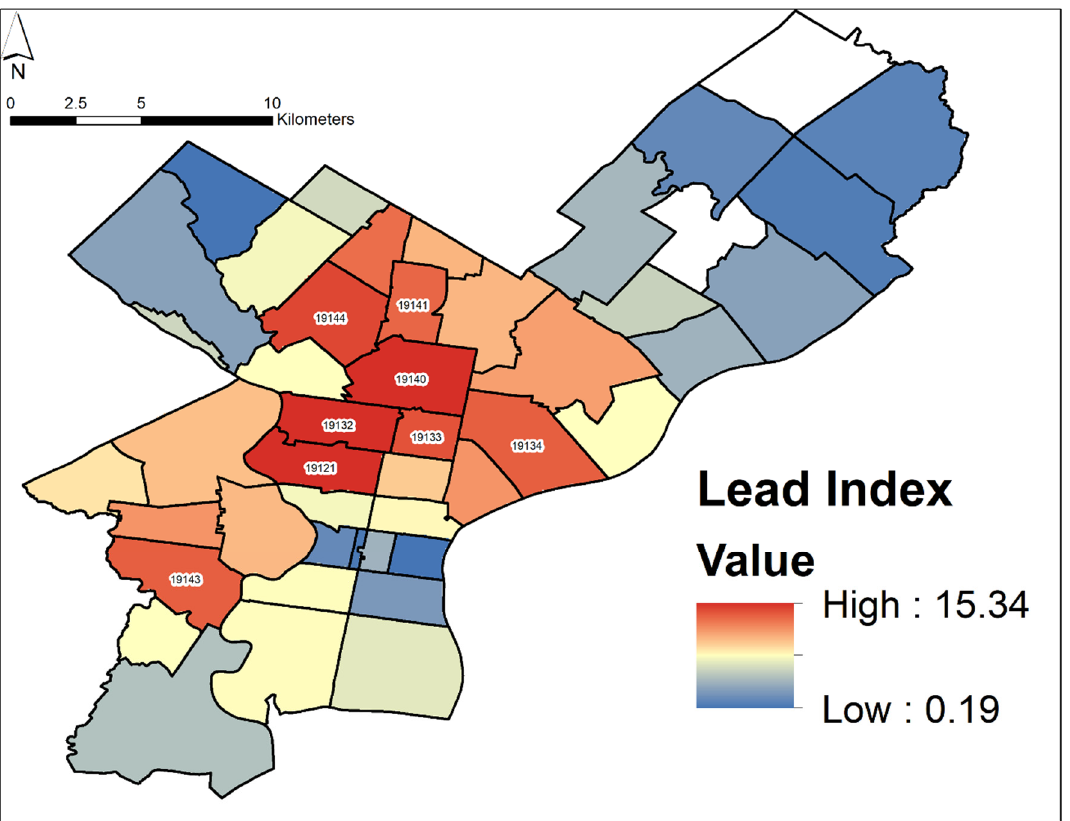
Figure 10. Calculated Lead Index —see the Methods section for full details on the model inputs. The ZIP codes with the highest values are labeled (19121, 19132, 19133, 19134, 19140, 19141, 19143, 19144).